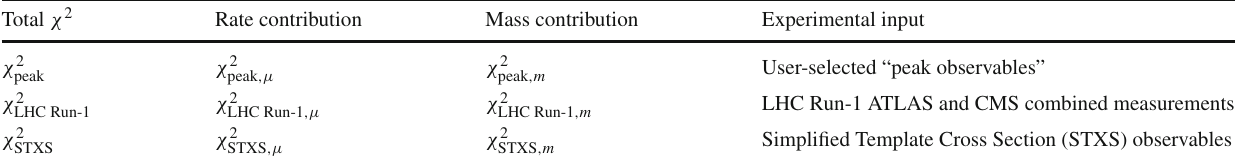
Table 3 Individual χ 2 contributions in HiggsSignals-2 . The total χ 2 (left column) is defined as the sum of the χ 2 contribution from the rate measurements (second column) and the χ 2 contribution from the mass measurements (third column) Total χ 2